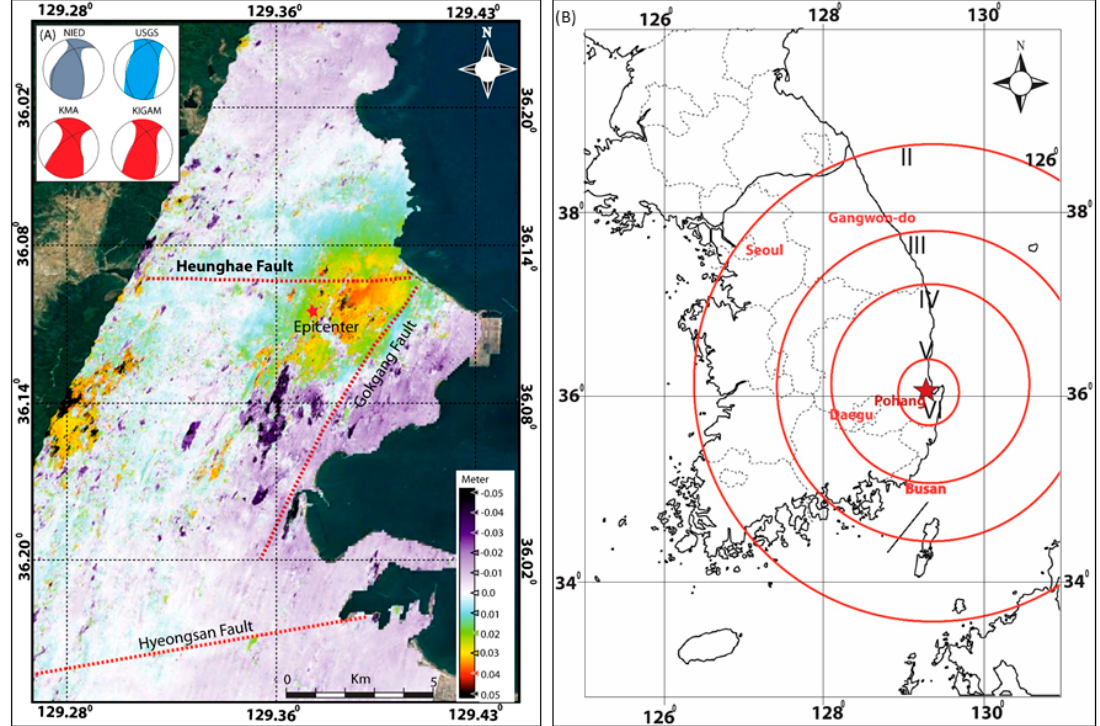
Figure 1. ( A ) InSAR image showing the deformation (~3–4 cm uplift) in the epicenter area, previously reported faults and the regional stress condition with focal mechanism (National Research Institute for Earth Science and Disaster Resilience (NIED), United States Geological Survey (USGS), Korean Meteorological Administration (KMA), and Korea Institute of Geoscience and Mineral Resources (KIGAM). ( B ) General Modified Mercalli intensity (MMI) distribution of Pohang earthquake, according to USGS. KMA suggested intensity of VIII to IX in the epicenter area.